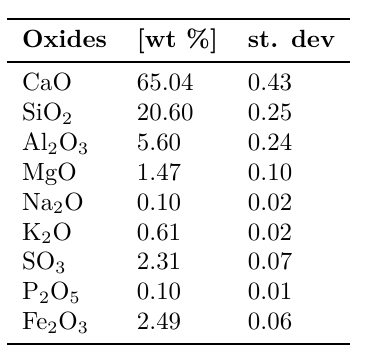
Table 1. Chemical composition of cement ID 133 determined by